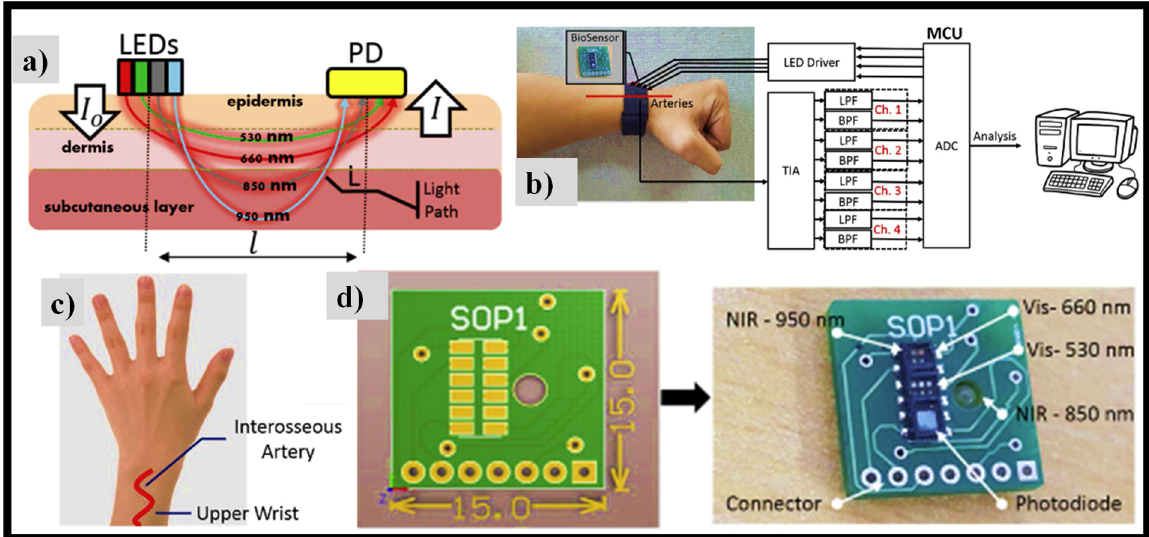
Figure 9. ( a ) Diffused reflectance PPG signal in multiple λ measurements [116]. Prototype system: ( b ) block diagram of analog signal processing [116], ( c ) sensing device wear location on the wrist [116], ( d ) the overall sensing device design on PCB [116]. Reproduced with permission from [116]. Elsevier B.V., 2019.